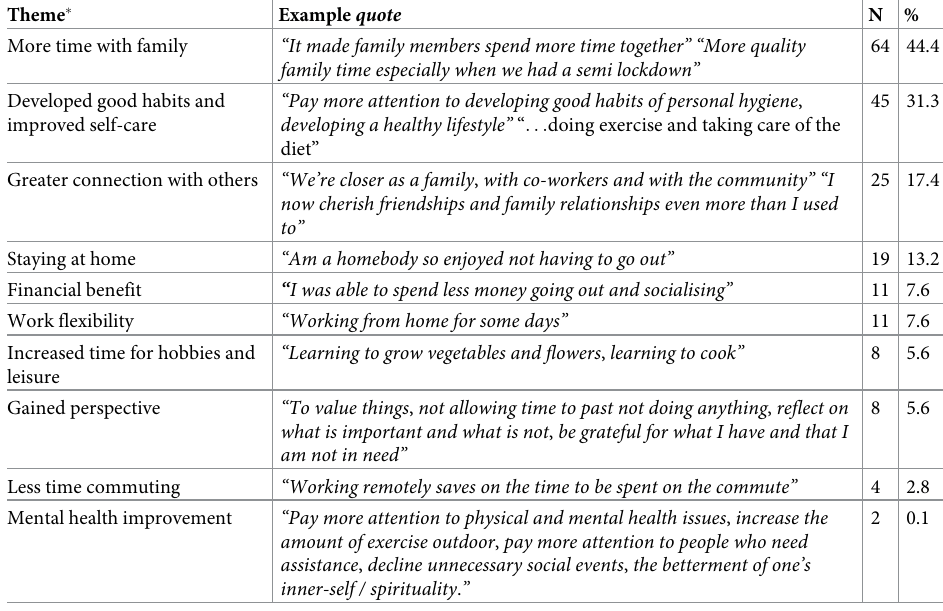
Table 2. Themes identified in free-text responses to question ‘In your life, have you had any positive effects from the COVID-19 pandemic’ with example quote, shown in decreasing order of frequency, of those who reported a